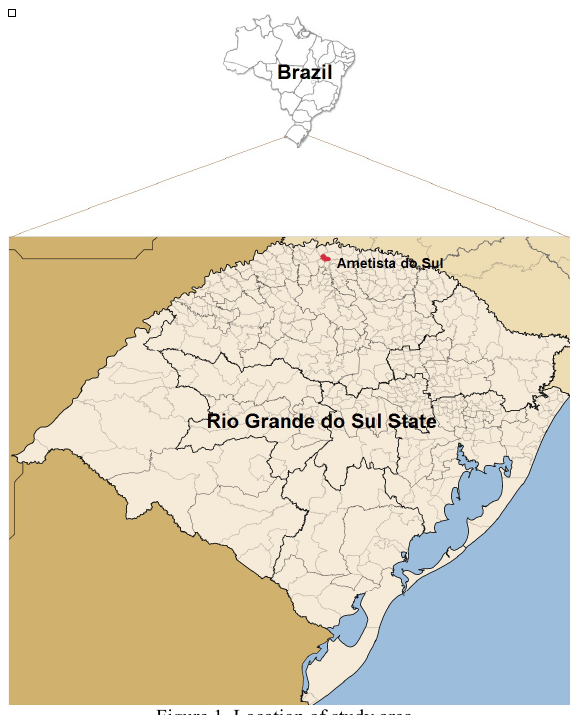
Figure 1. Location of study area.